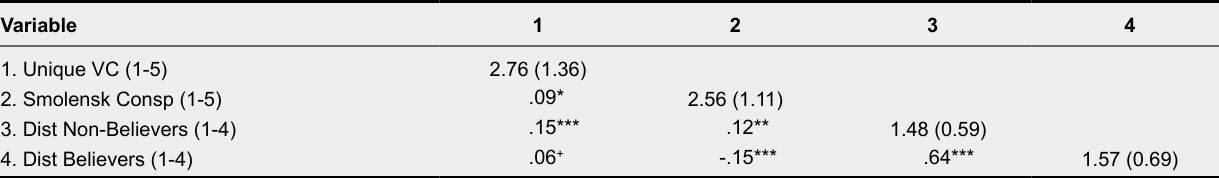
Correlations and Descriptive Statistics